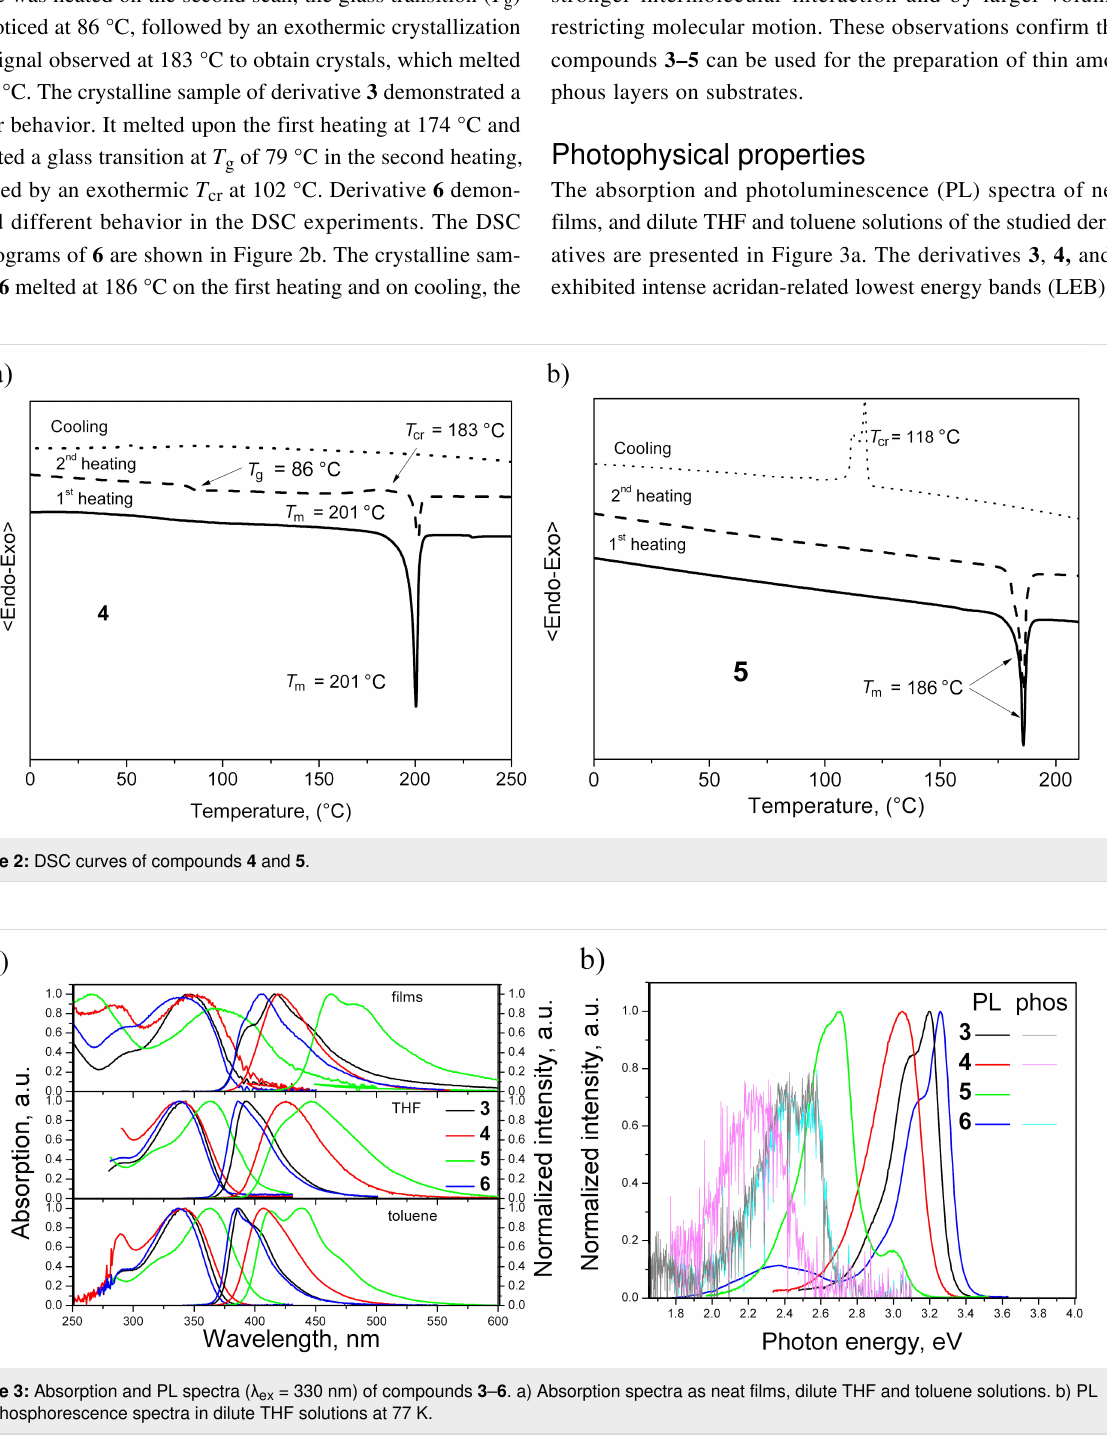
Figure 3: Absorption and PL spectra ( λ ex = 330 nm) of compounds 3 – 6 . a) Absorption spectra as neat films, dilute THF and toluene solutions. b) PL and phosphorescence spectra in dilute THF solutions at 77